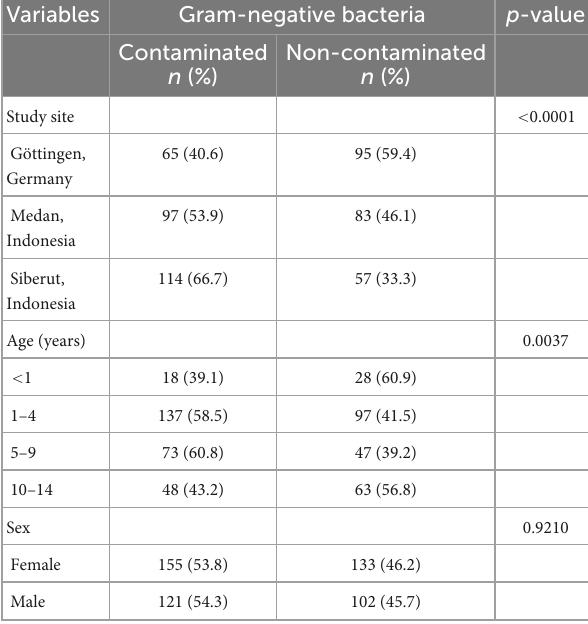
TABLE 3 Association between hand contamination and sociodemographic